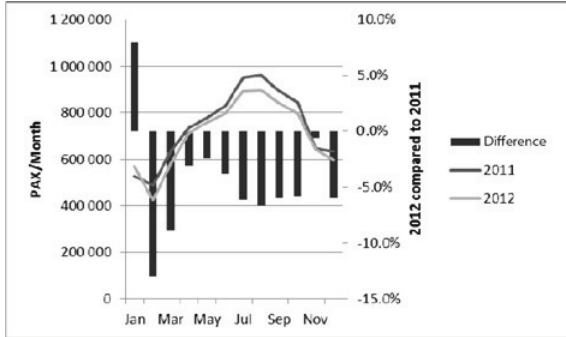
fig. 5. Demand changes 2012 vs. 2011 at BUD (Source: own edition based on Hungaro Control Data)